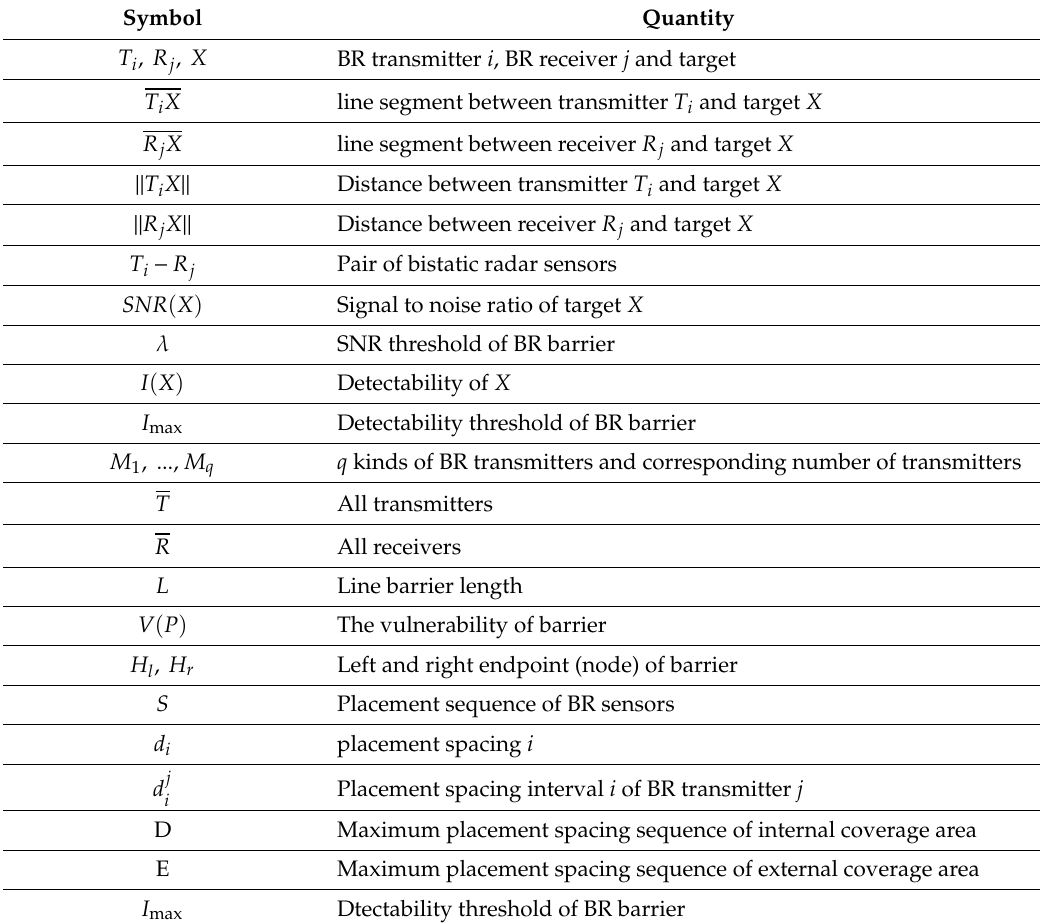
Table 1. Parameter